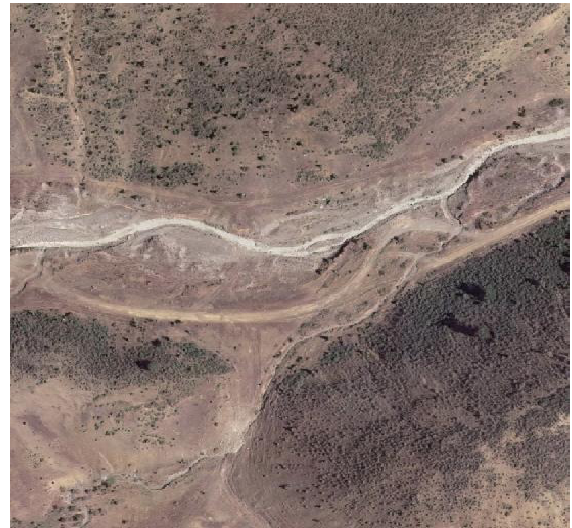
Fig.5 10 cm GSD